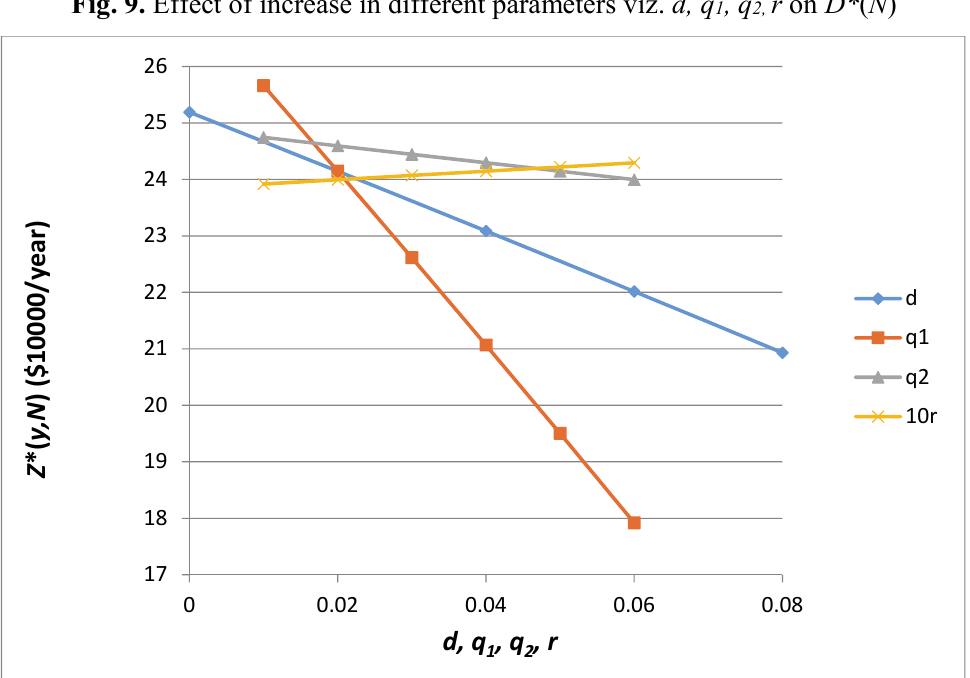
Fig. 10. Effect of increase in different parameters viz. d, q 1 , q 2, r on E[ Z* ( y,N